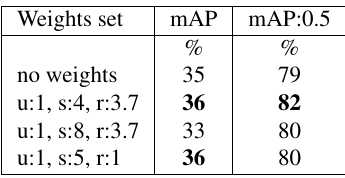
Table 6. Class weights search experiments.